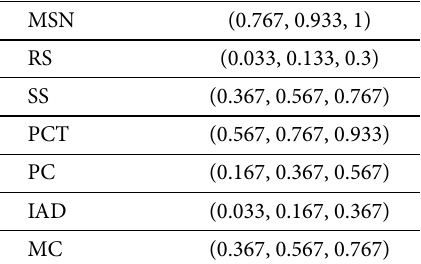
Table 6. The linguistic evaluation of criteria Table 7. The weights of